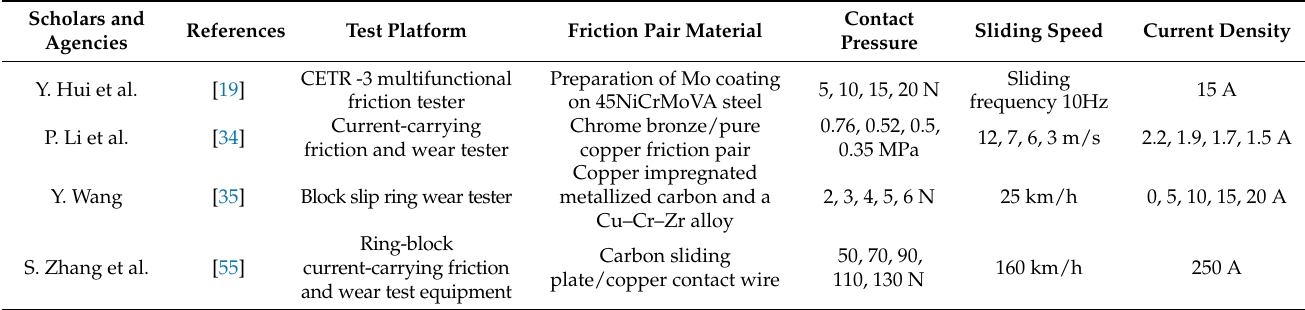
Table 3. The load related research.